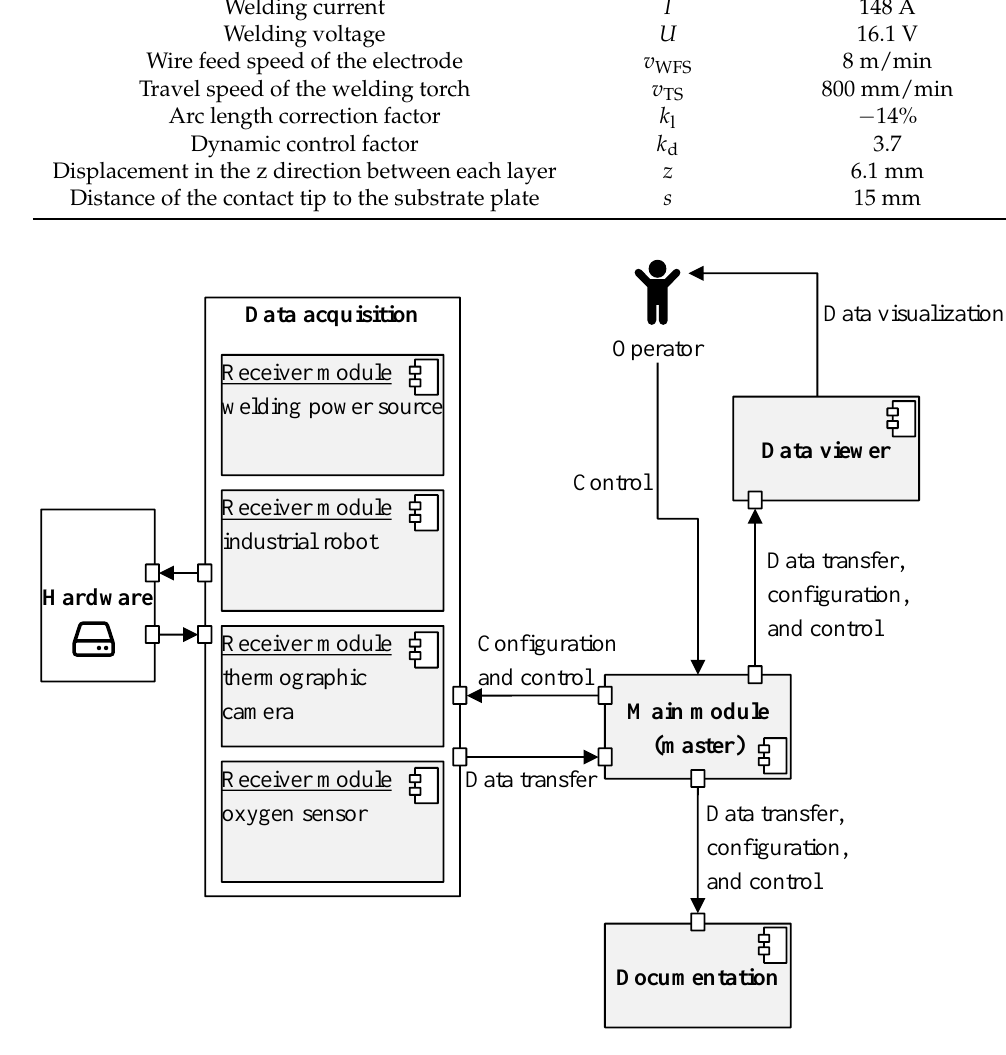
Figure A1. System architecture of the OQAS for computing the data.